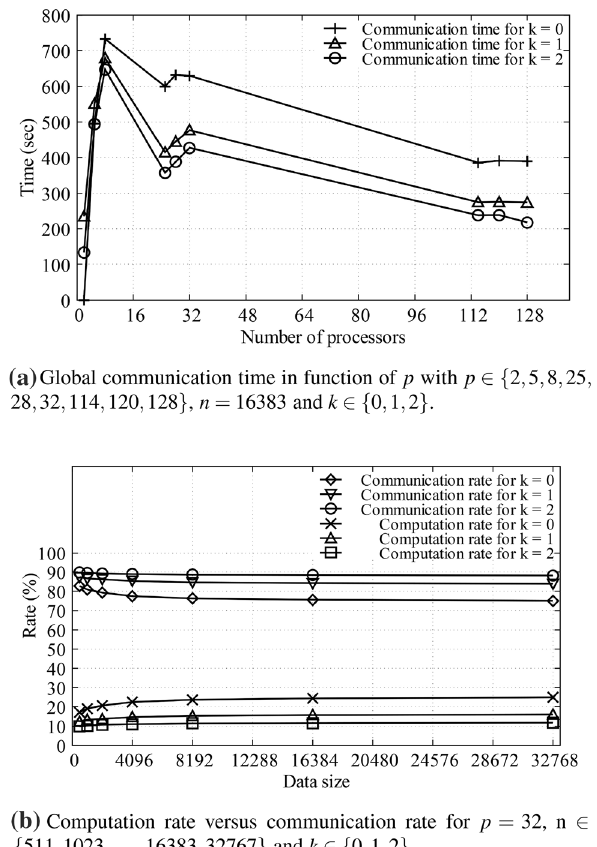
Fig. 10 Total execution time in function of p and